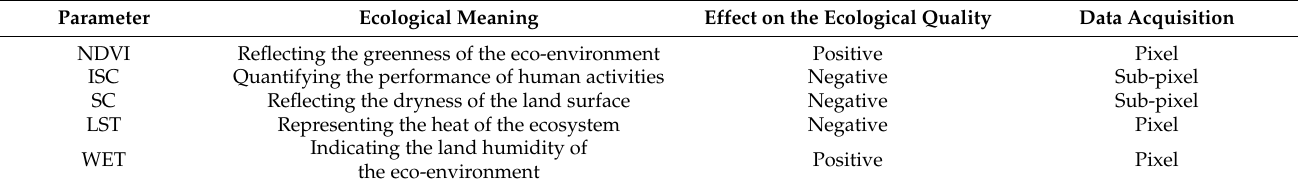
Table 2. The ecological meaning of the five parameters. Parameter Ecological Meaning Effect on the Ecological Quality